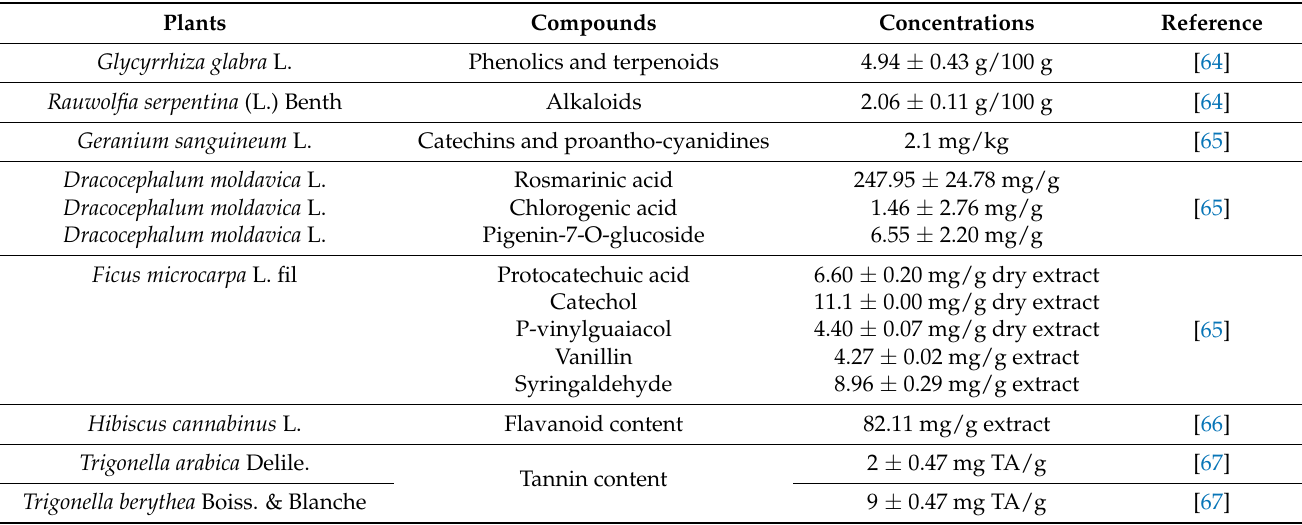
Table 2. Phenolic compounds and flavonoids concentration identified in